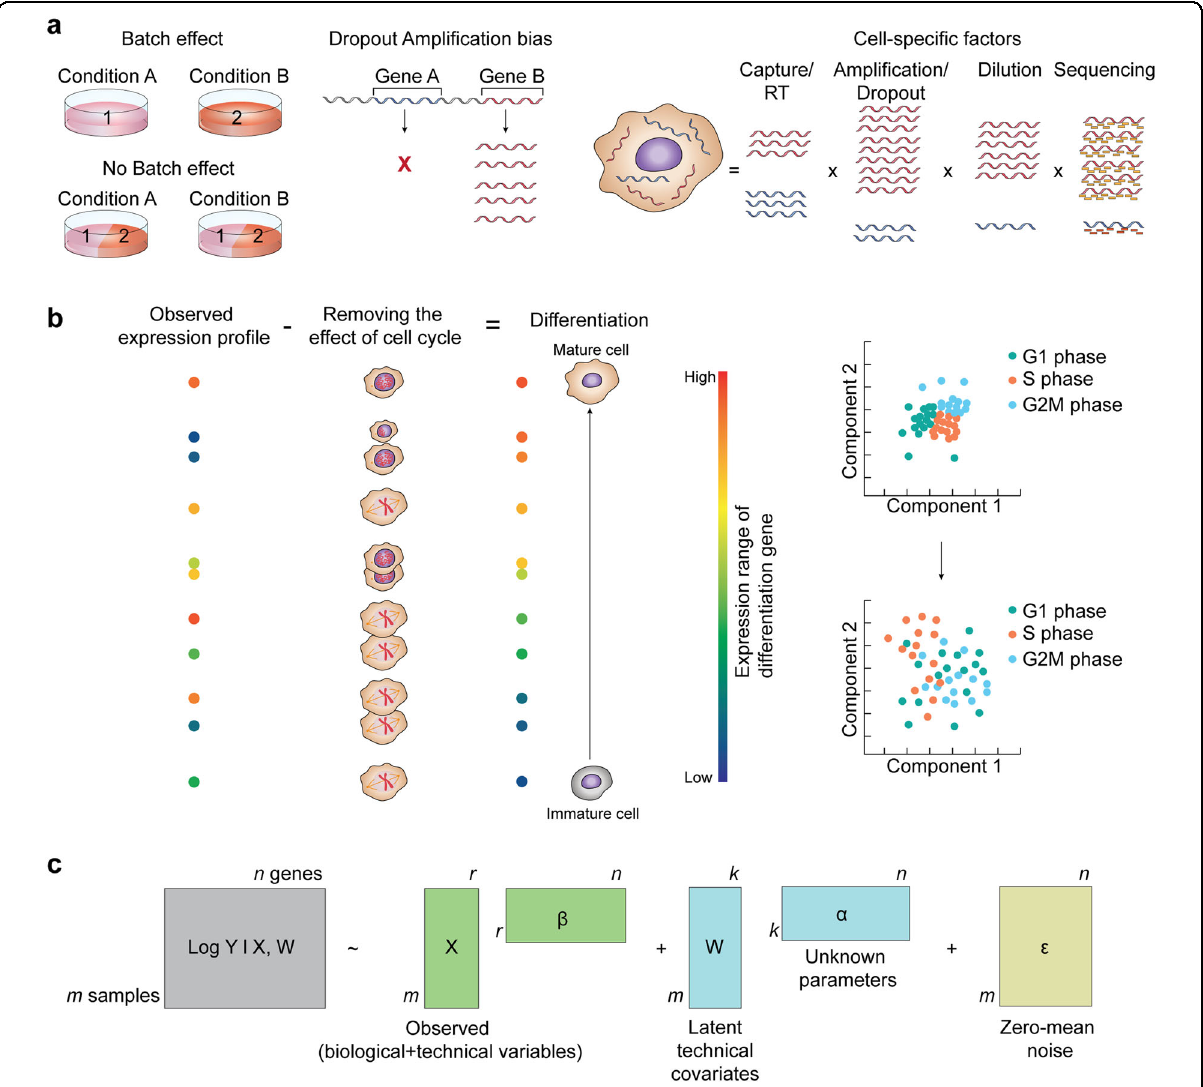
Fig. 4 Addressing confounding factors in scRNA-seq. a Technical batch effects are a well-known problem in scRNA-seq when the experiment (condition) is conducted in different plates (environment). Cell-speci fi c scaling factors, such as capture and RT ef fi ciency, dropout/ampli fi cation bias, dilution factor, and sequencing amount, must be considered in the normalization step. b Single-cell latent variable model (scLVM) can effectively remove the variation explained by the cell-cycle effect. The clear separation is lost in scLVM-corrected expression data using PCA (visualization adapted from ref. 59 ). c The expression value y can be modeled as a linear combination of r technical and biological factors and k latent factors with